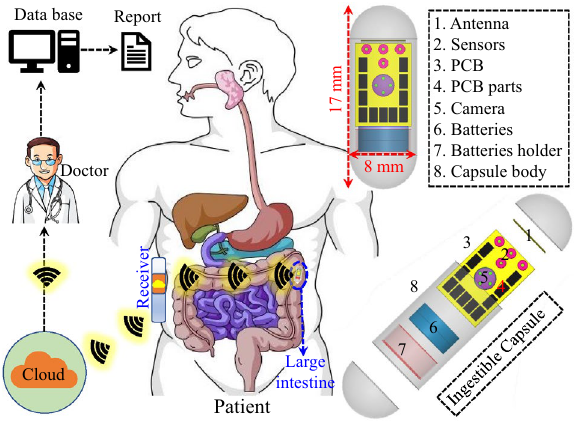
Figure 1. The concept of wireless patient monitoring system using ingestible